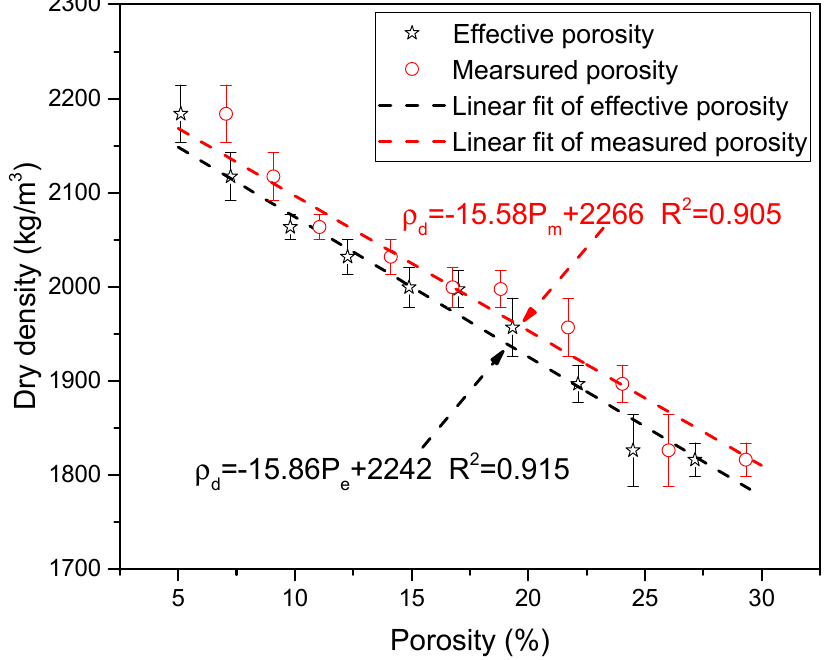
Figure 7. Dry Density of the pervious concrete and its relationship versus the effective porosity and measured porosity.